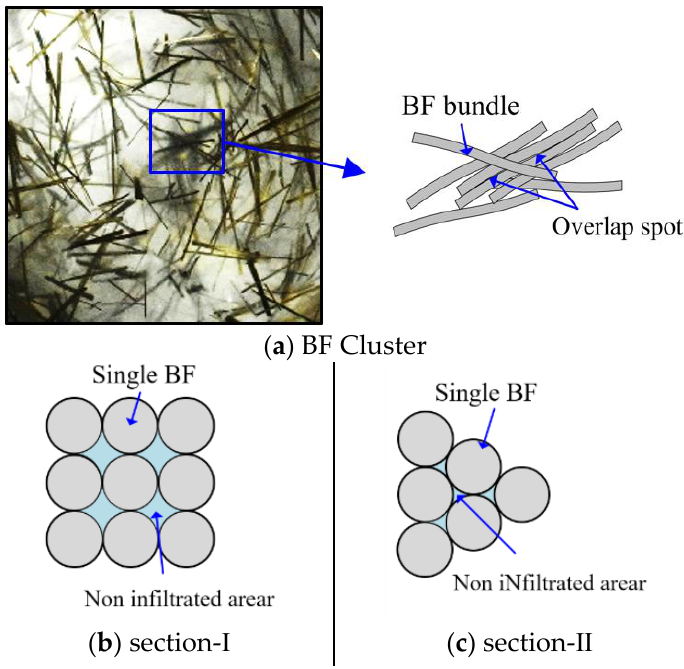
Figure 10. Cement-based unfilled area between fiber clusters.